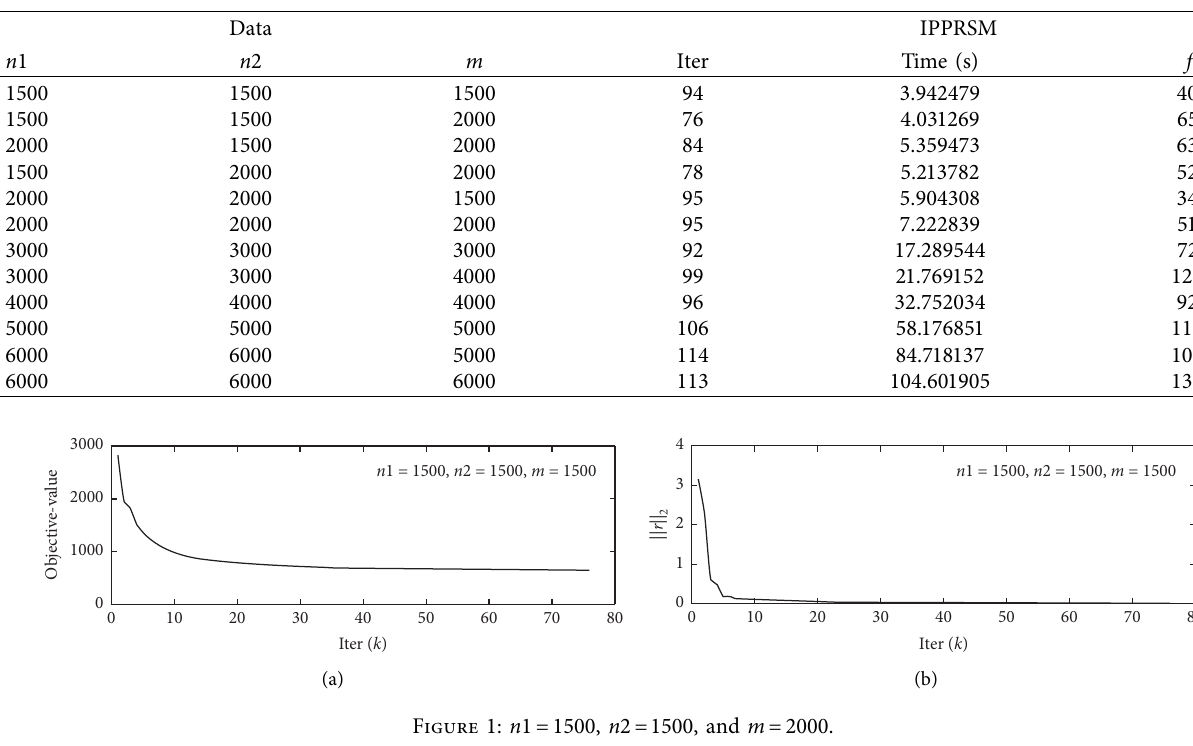
Table 1: Numerical results.